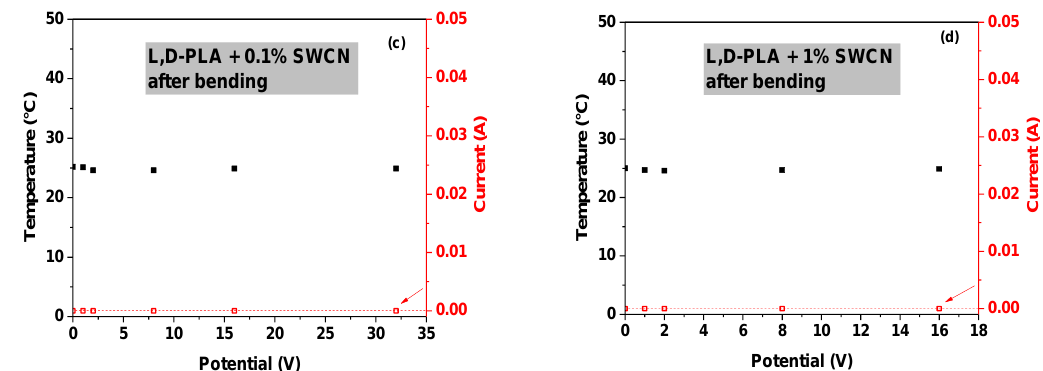
Figure 10. The correlation of temperature and current at different applied potentials for L , D -PLA film ( a ), and films based on L , D -PLA containing 0.01% ( b ), 0.1% ( c ) and 1% ( d ) SWCN; after mechanical deformation.